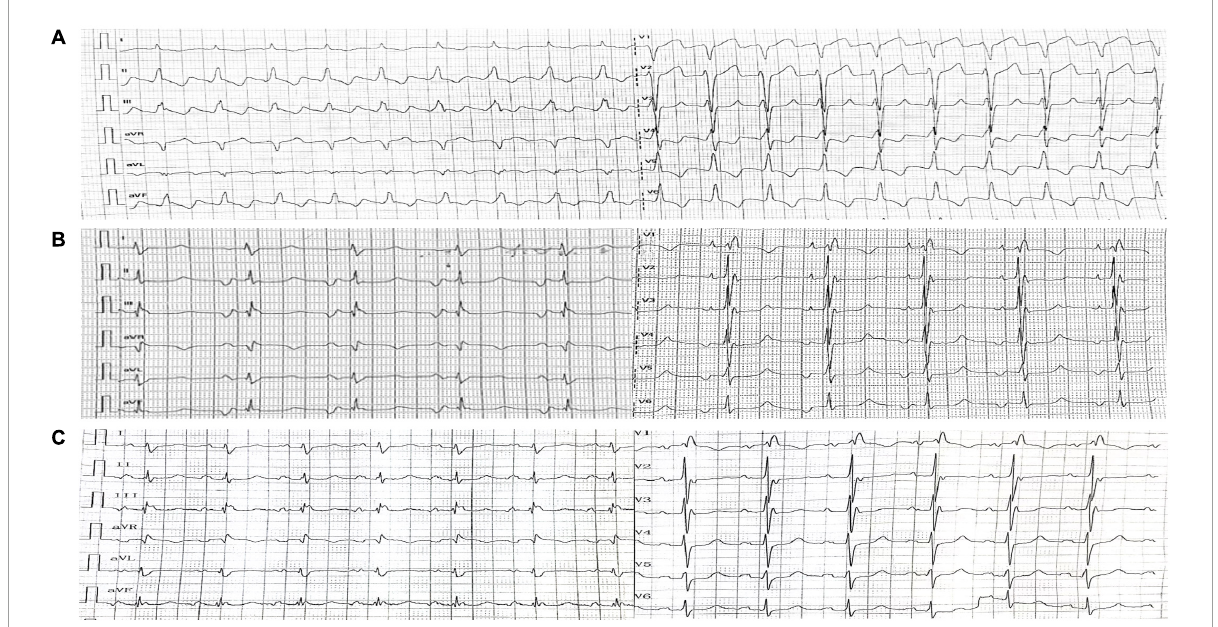
FIGURE1 Electrocardiography. (A) Electrocardiography upon admission showed Type I atrial flutter. (B) Post-operative electrocardiography (1st day) showed coronary sinus rhythm. (C) Post-operative electrocardiography (8th day) showed recovered sinus rhythm.